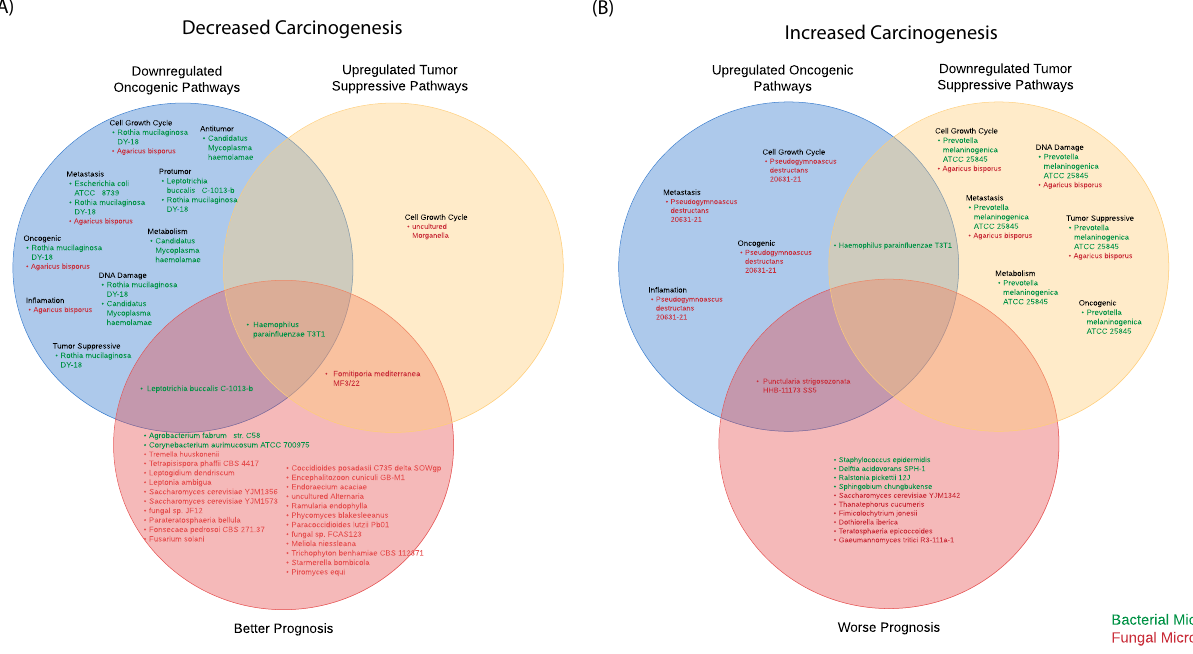
Figure 10. Identification of microbes as predictors of increased or decreased carcinogenesis. Venn diagrams comparing significantly dysregulated microbes in association with pathways relevant to increased or decreased carcinogenesis. Green corresponds to bacterial microbes, while red corre- sponds to fungal microbes. ( A ) Decreased carcinogenesis was characterized by upregulation of tumor-suppressive pathways, downregulation of oncogenic pathways, and better patient